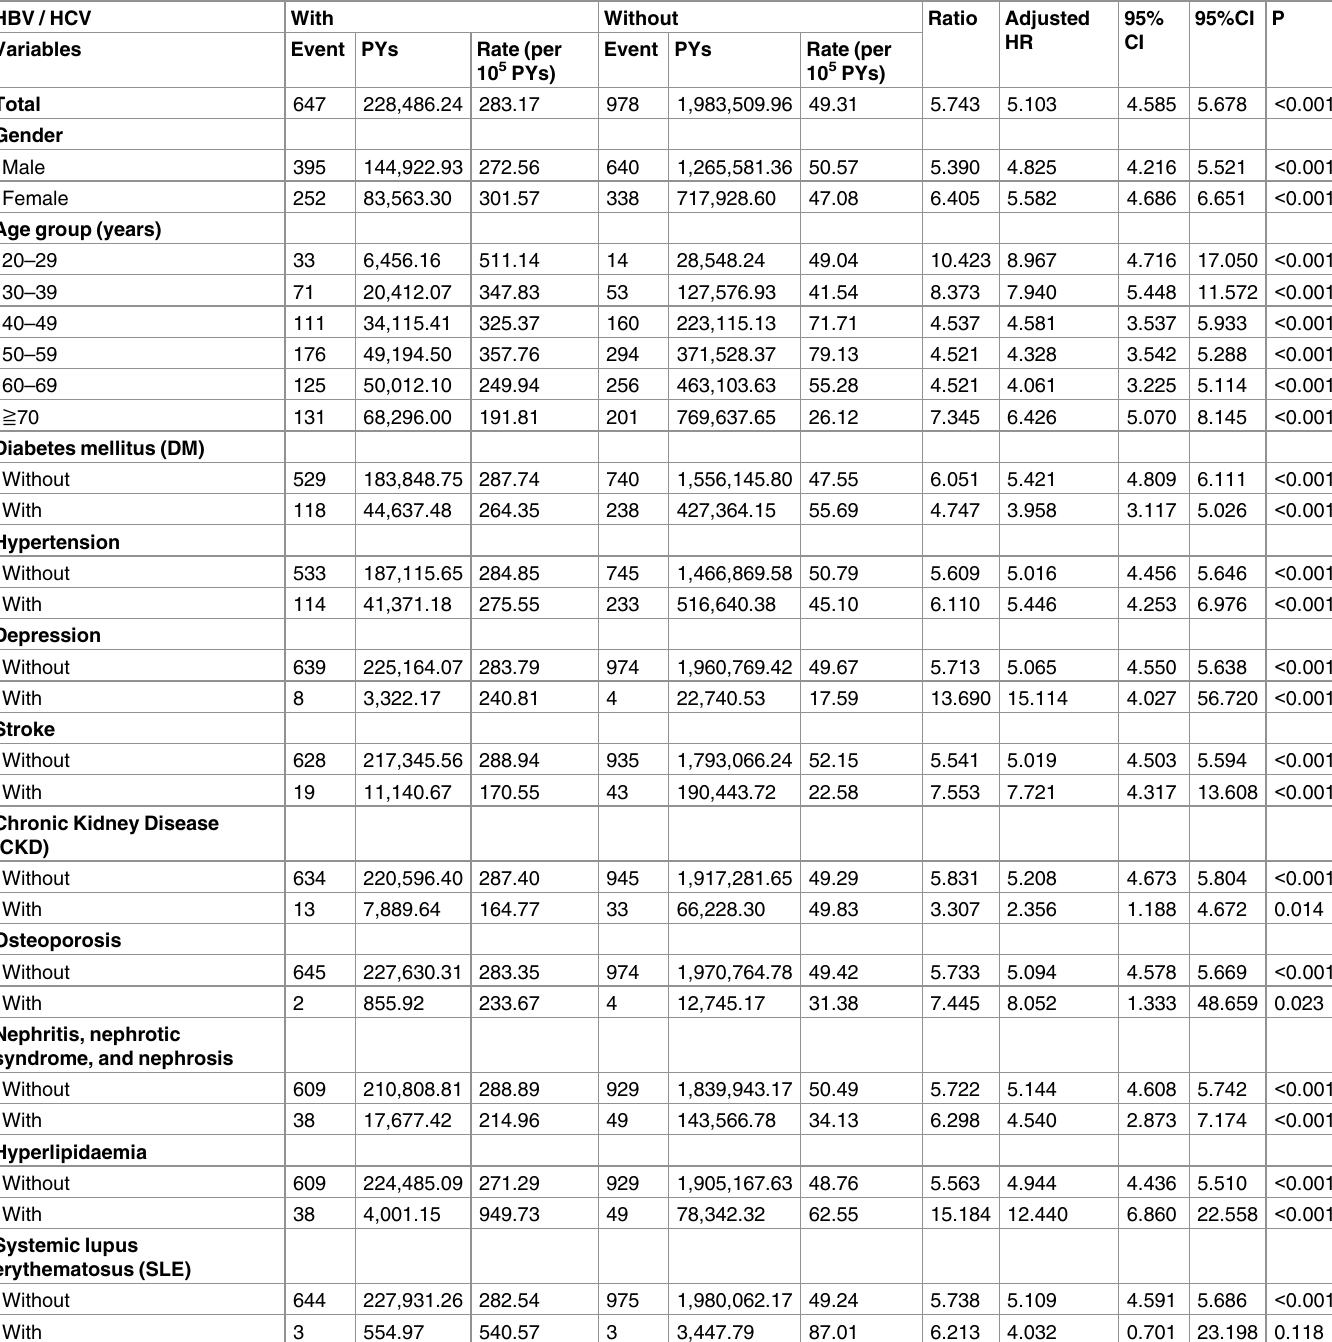
Table 2. Factors for sudden sensorineural hearing loss at the end of follow-up, stratified by variables assessedthrough Cox regression analysis. HBV /